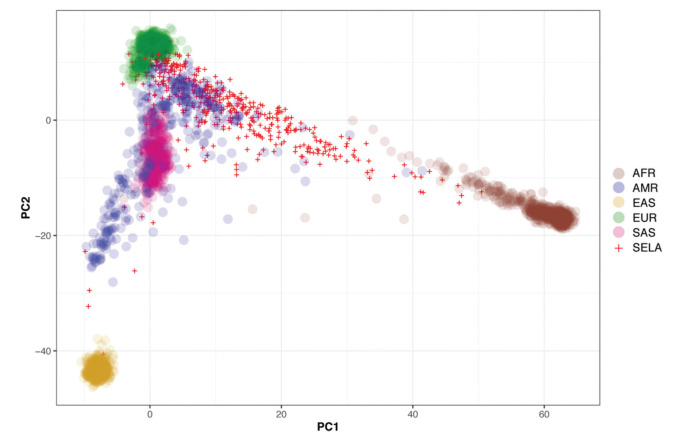
Biplot depicting the two principal components (x-axis: PC1, y-axis: PC2) capturing the highest genetic variation among different populations from 1000 Genomes (colored circles) and SELAdb individuals (red crosses). Each circle or cross represents a single individual. The populations represented by the colored circles are African (AFR), Ad-Mixed American (AMR), East Asian (EAS), European (EUR), and South Asian (SAS).